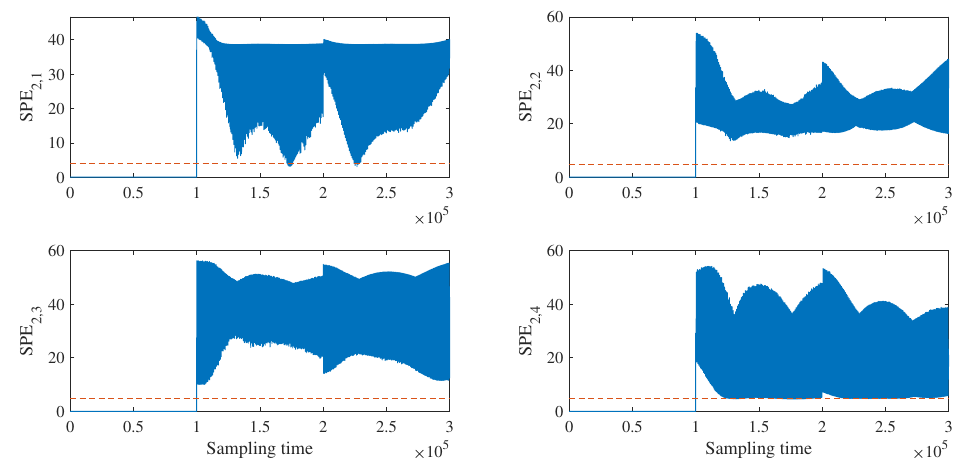
Figure 18. Deep PCA-based fault detection for f 2 with FNR enhancement.